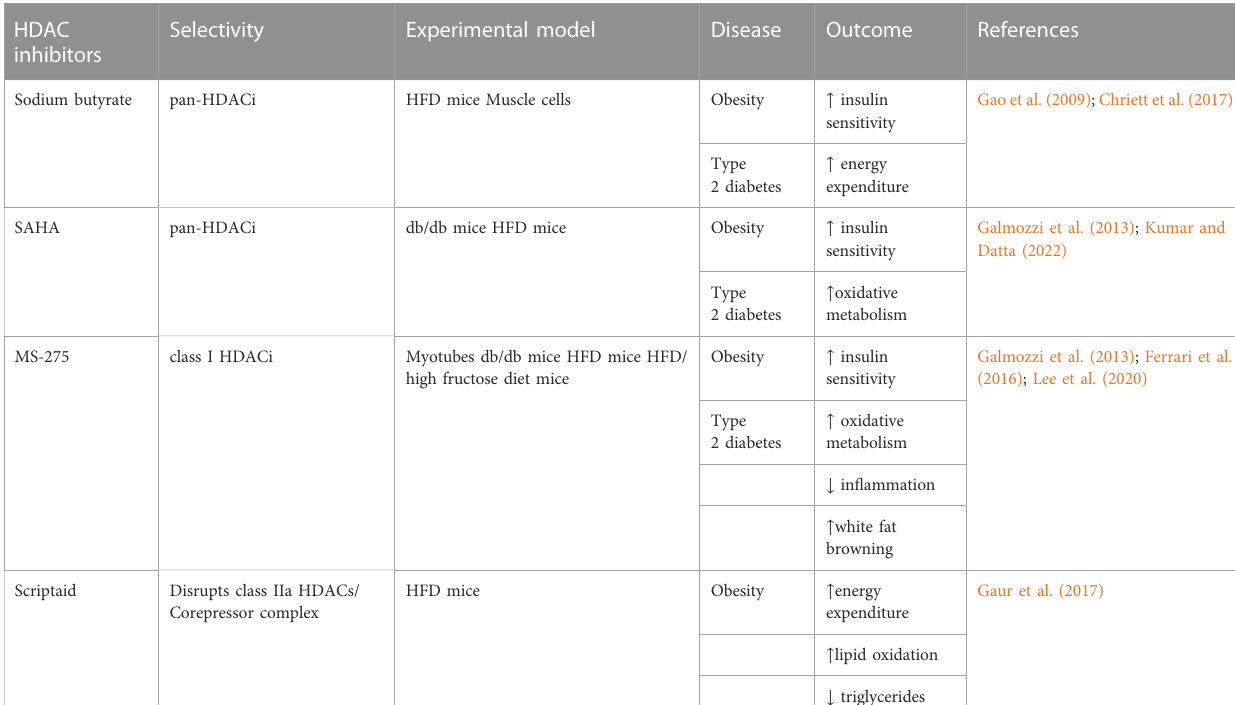
TABLE 2 Potential therapeutic applications for the use of HDACi in metabolic